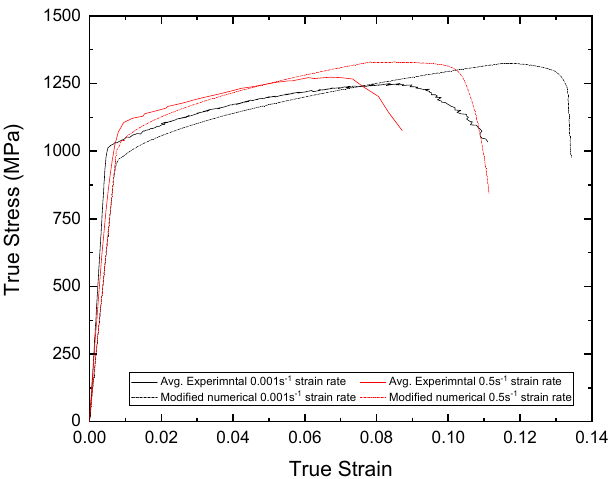
Figure A4. True stress–strain plot comparison for 0.001 s − 1 and 0.5 s − 1 strain rates for average experimental and numerical simulation using JC damage parameters of Table A1.